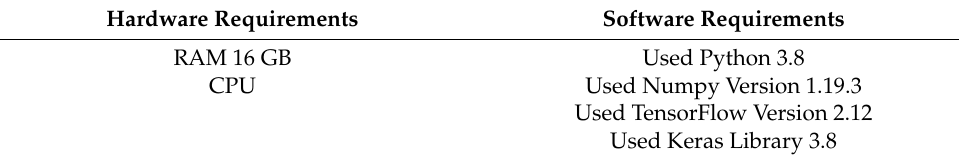
Table 4. The system’s environmental preconditions and requirements.